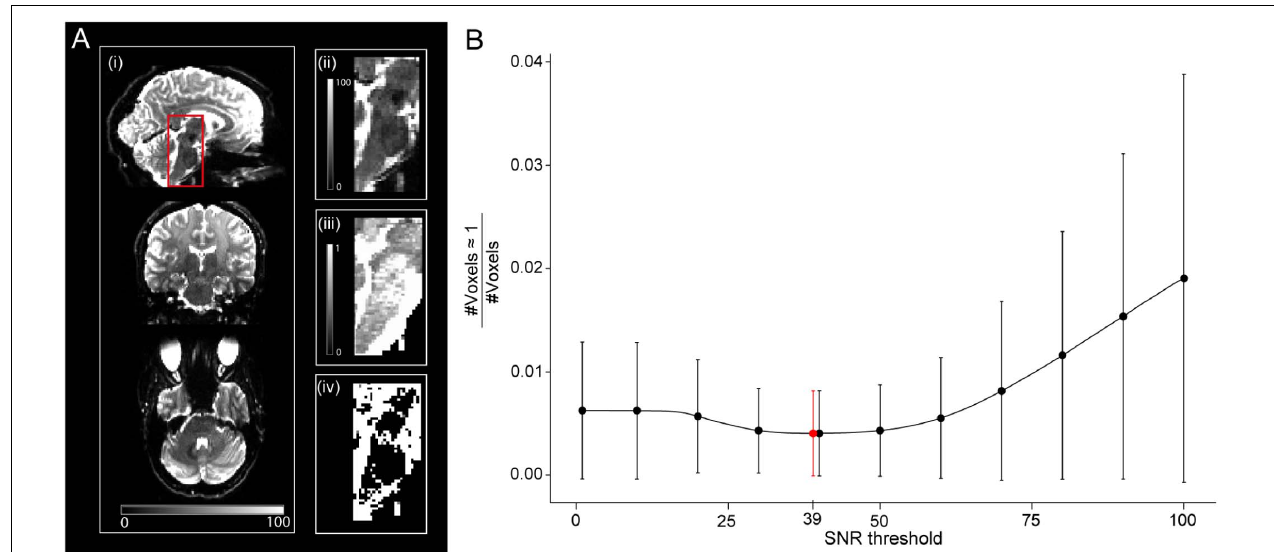
FIGURE 3 | Relationship between signal-to-noise ratio (SNR) and unrealistically high ν icvf values—here defined as ν icvf ≥ 0 . 999. (A) Sagittal, coronal, and axial view of the whole-brain SNR map (i), with a zoom-in view of the brainstem (ii). The brainstem is characterized by low SNR due to the spatial characteristics of the receive coil array (ii) and high occurrence of unrealistically high ν icvf (iii), also shown as a binary mask (iv). (B) Given the co-occurrence of low SNR and unrealistically high ν icvf , a binary SNR mask was created to exclude low-SNR voxels. To determine the optimal threshold for the SNR mask, the ratio between the number of voxels with unrealistically high ν icvf and the total number of voxels within the mask were plotted against the SNR threshold. The solid dots and error bars represent the group mean and group standard deviation of the ratio, respectively. The SNR value that yielded the minimum of this ratio was considered optimal (SNR = 39, shown in red).